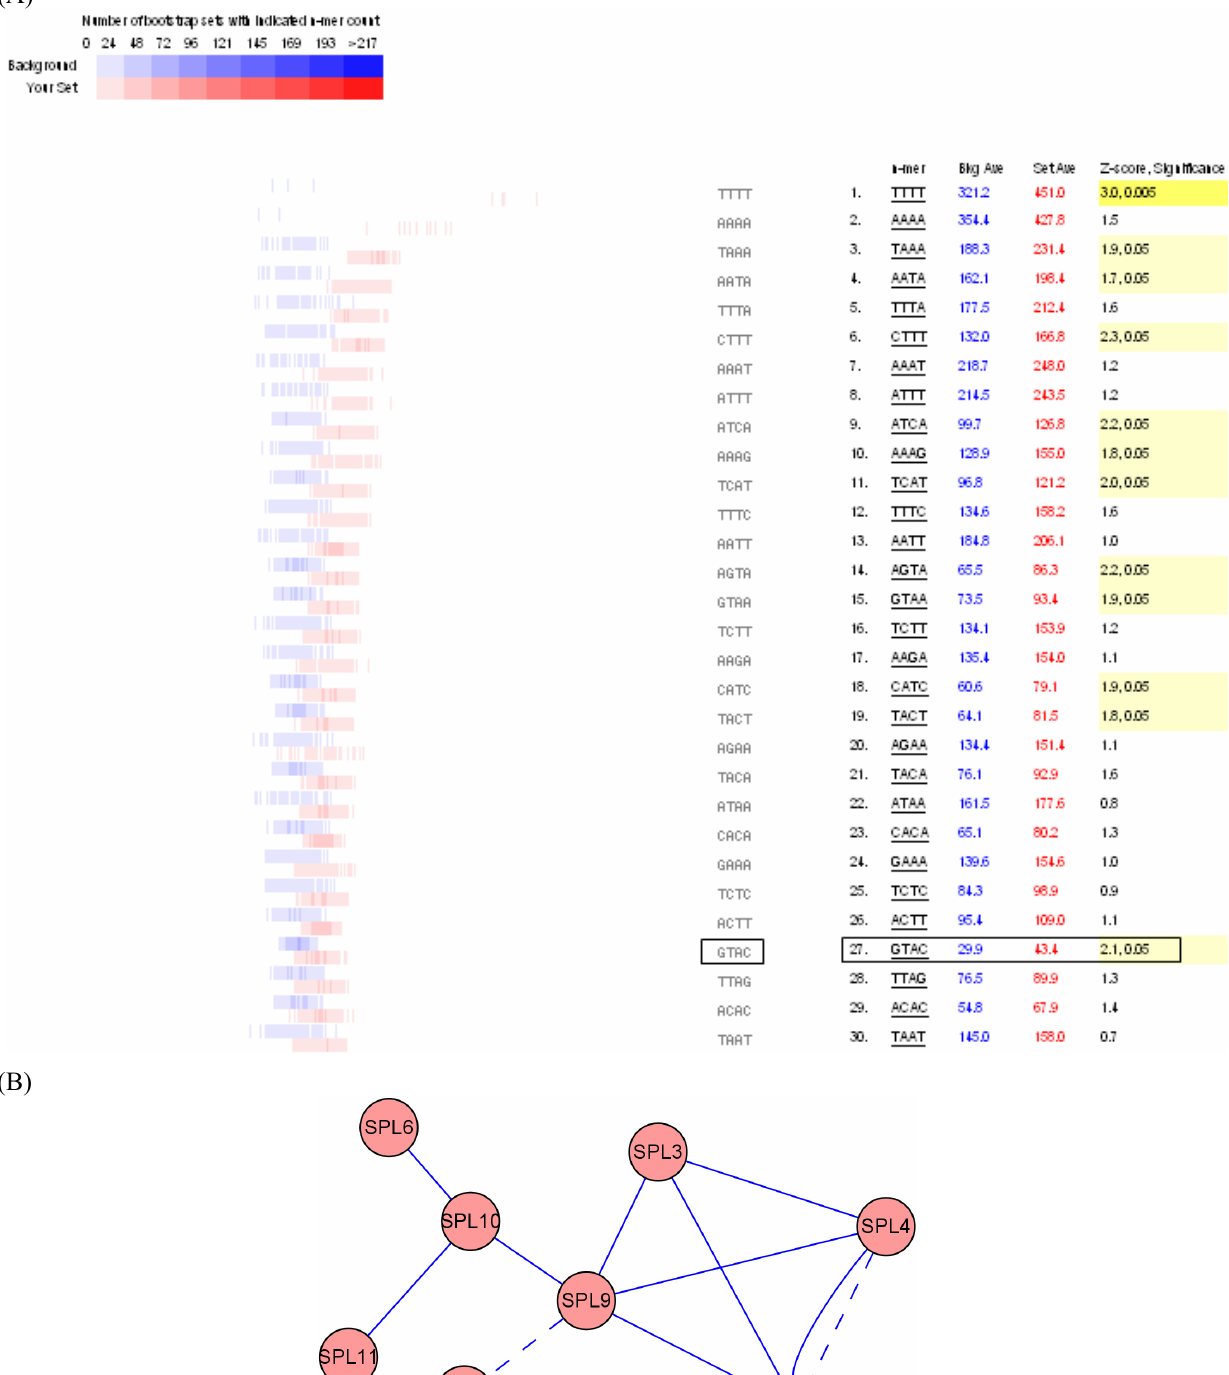
Figure 5. Promoter and network analysis of SPL genes. (A) The distribution of the occurrence of the GTAC motif in 1000 sets of SPL genes promoters randomly selected from the Arabidopsis genome. Distribution in 1,000 randomly generated promoter sets: Average 29.7. Distribution in 1,000 bootstraps of our promoter set: Average 42.9. Z-score, Significance: 2.2,0.05. (B) A putative network of SPL genes (a solid line indicates co-expression, and a dashed line indicates protein